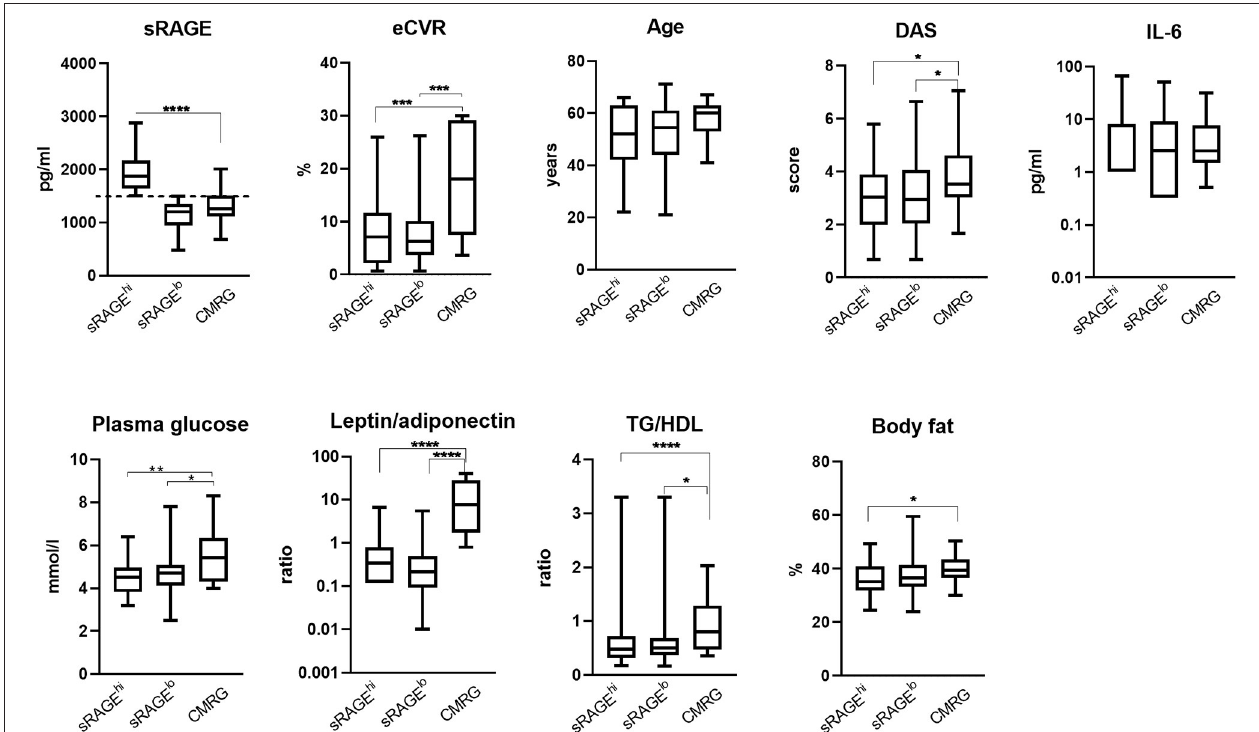
FIGURE 1 | Metabolic and inflammation-related characteristics of female patients with rheumatoid arthritis. Serum levels of soluble receptor for advanced glycation end products (sRAGE) were measured in 184 patients and the patients with no previous cardiovascular events were divided into the high (sRAGE hi , n = 73) or low (sRAGE lo , n = 98) groups, accordingly. Cardio-metabolic reference group (CMRG) consisted of patients with history of cardiovascular events and/or type II diabetes ( n = 13). SRAGE in the upper quartile of CMR group (above 1,504 pg/ml, indicated with dotted line) defined the cut-point for dichotomization. Statistical evaluations were calculated using the Mann-Whitney U -test. The box plots indicate medians and interquartile ranges; whiskers show min to max. * P < 0.05; ** P < 0.01; *** P < 0.001; and **** P < 0.0001. TG/HDL, ratio between serum triglycerides and high-density lipoproteins; DAS28, disease activity score; IL,